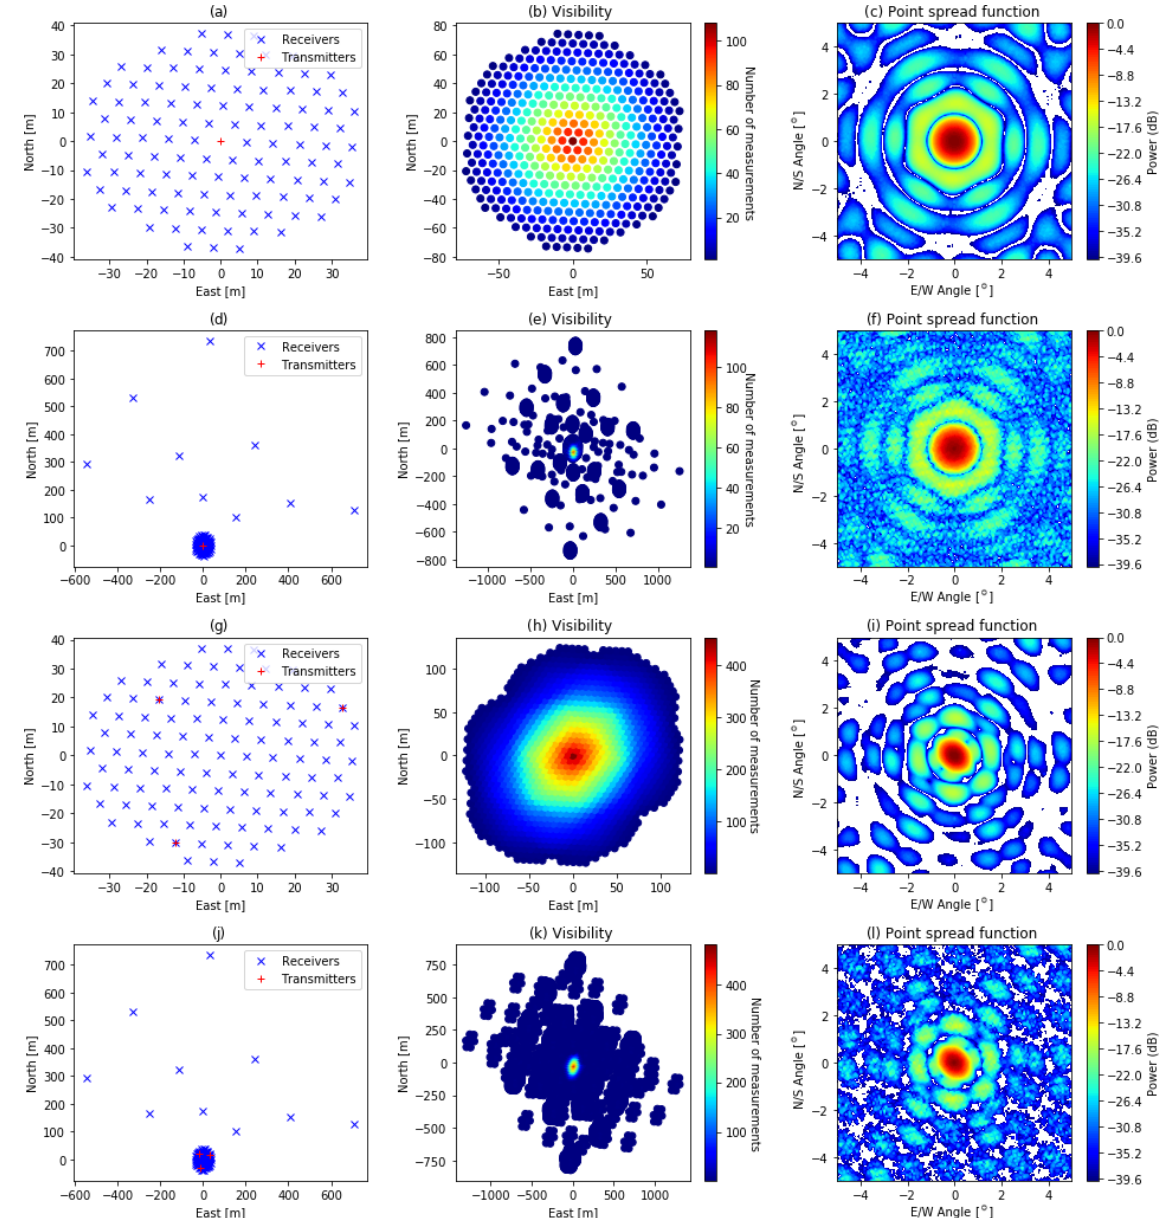
Figure 7. E3D transmitter–receiver layouts considered. Panels (a) , (d) , (g) , and (j) show the layouts, panels (b) , (e) , (h) , and (k) show the visibilities, and panels (c) , (f) , (i) , and (l) show the point spread function in the near field at 100km range. The point spread function was calculated by reconstructing a 1 × 1 one-valued central pixel in a 129 × 129 zero-valued pixel image with a matched filter. Panel (a–c) uses the whole core array as a single transmitter and receives with each of the 109 antenna groups in the core array. Panel (d–f) also includes the interferometric outriggers. In panel (g–i) only the core is used, but it is divided into three transmitters. Finally, panel (j–l) uses both the outriggers and multiple